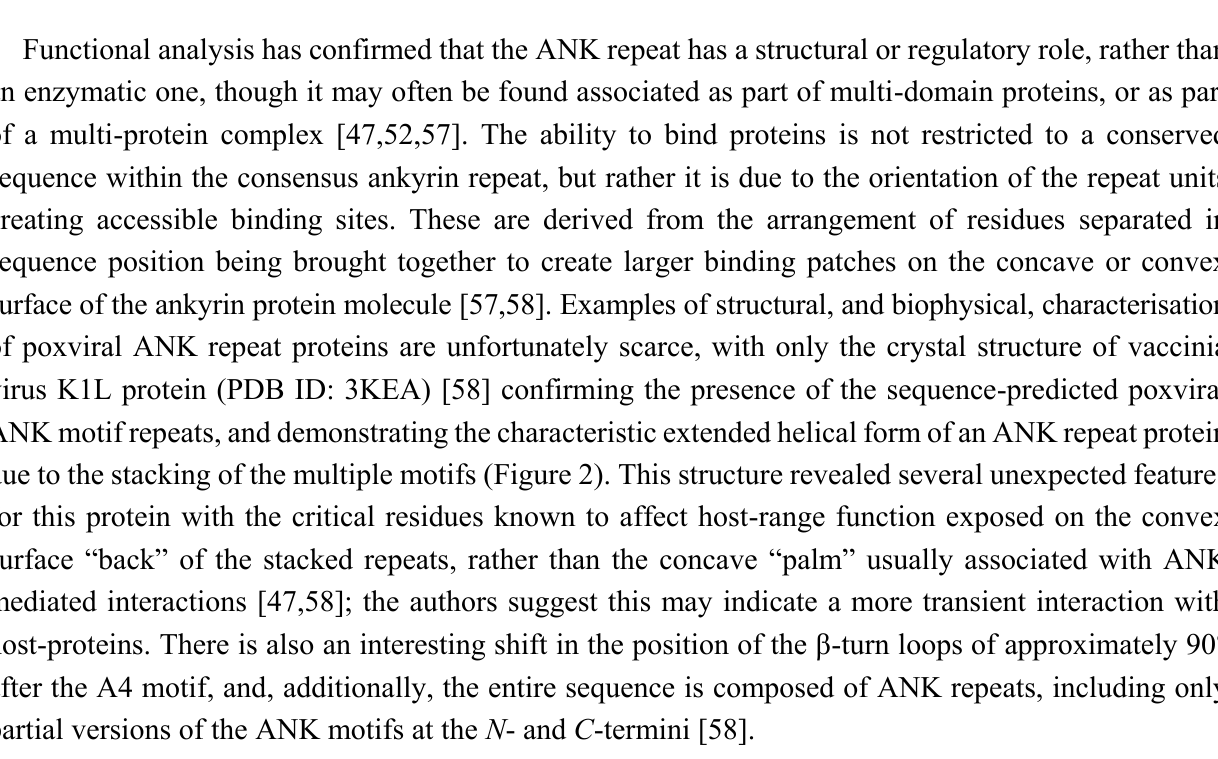
Figure 1. The ANK repeat unit from the ankyrinR protein. Example of an ANK motif highlighting the 5 th repeat unit in the ankyrinR structure (PDB ID: 1N11) [52]. β-turns (orange) within the loops (green) link the helix pairs and project outwards in a conserved manner at an angle of approximately 90° from the α-helices (purple) [47,52,56]. This arrangement has been likened to a “cupped hand” where the convex surface forms the “back” ( a )’ the concave surface the “palm” ( b )’ and the loops form the “fingers” ( c ). Blue and red indicate the N - and C -termini